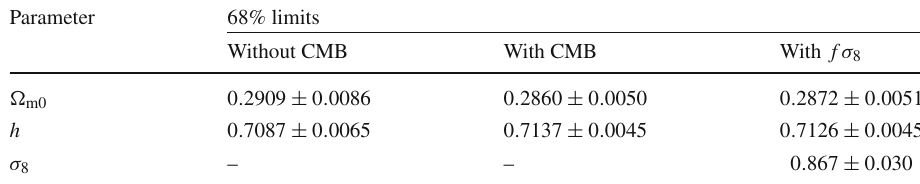
Table 2 The best fit value of free parameters and 1 σ uncertainties using different data sets for PEDE model in flat universe